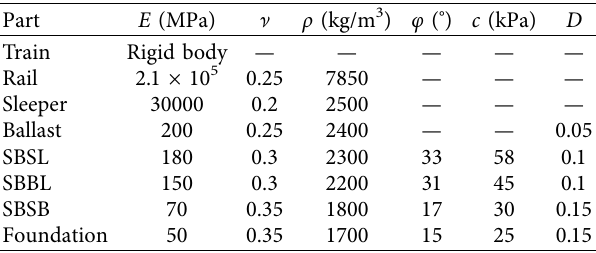
Figure 4: Connection between the rail and sleeper. Table 3: Mechanical parameters of different parts of the FE